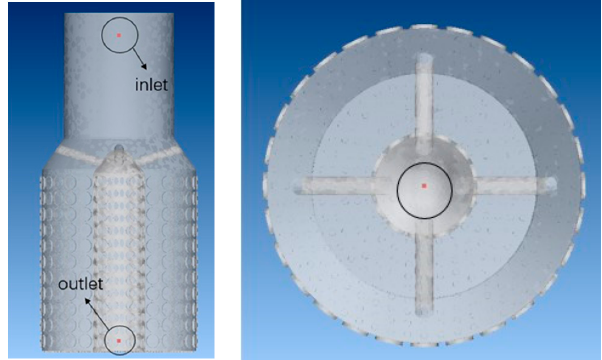
Figure 5. Sound field calculation monitoring